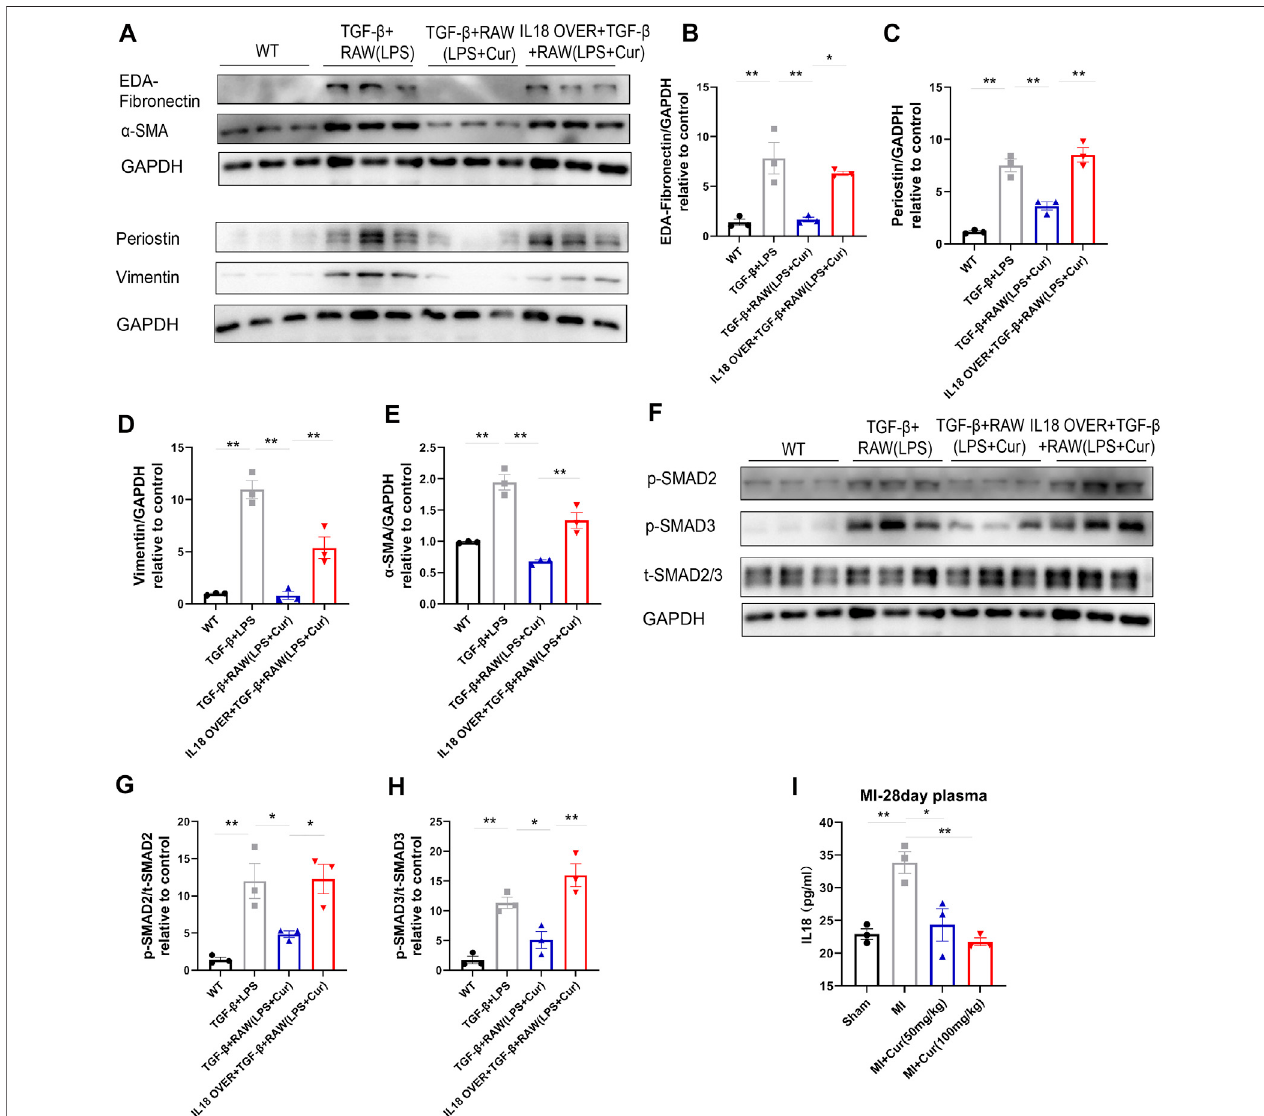
FIGURE 6 | IL-18 compensation represses curcumin-induced inhibition of SMAD2/3 phosphorylation and fi brotic gene expression (A – E). Fibrotic protein expression indifferent NRCFgroups (WT,TGF- β +RAW(LPS), TGF- β +RAW (LPS +Cur), IL18over +TGF- β +RAW(LPS +Cur)) respectively, fi broticproteins arede fi ned as EDA-Fibronectin, Periostin, Vimentin,and α -SMA.Summarydata ofprotein expression are displayed in (B – E) . EDA-Fibronectin isplotted in (B), Periostinisplotted in (C) , Vimentin is plotted in (D) and α -SMA in (E) (F-H). Phosphorylation level of SMAD2/3 in different NRCF groups (WT, TGF- β +RAW (LPS), TGF- β +RAW (LPS